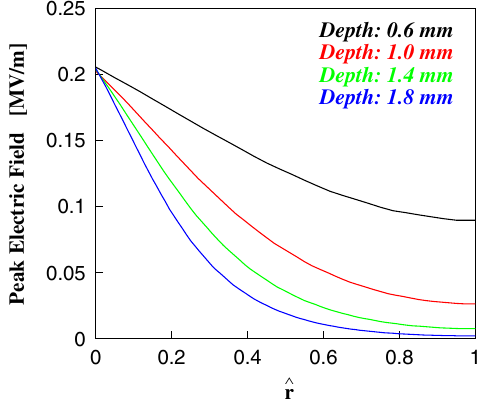
FIG. 9. Peak electric field at z ¼ 1 : 0 mm as a function of ^ r for a pitch of 2.0 mm and various depths for an input rf power of 1 MW (CW), obtained by the simulation using GDFIDL